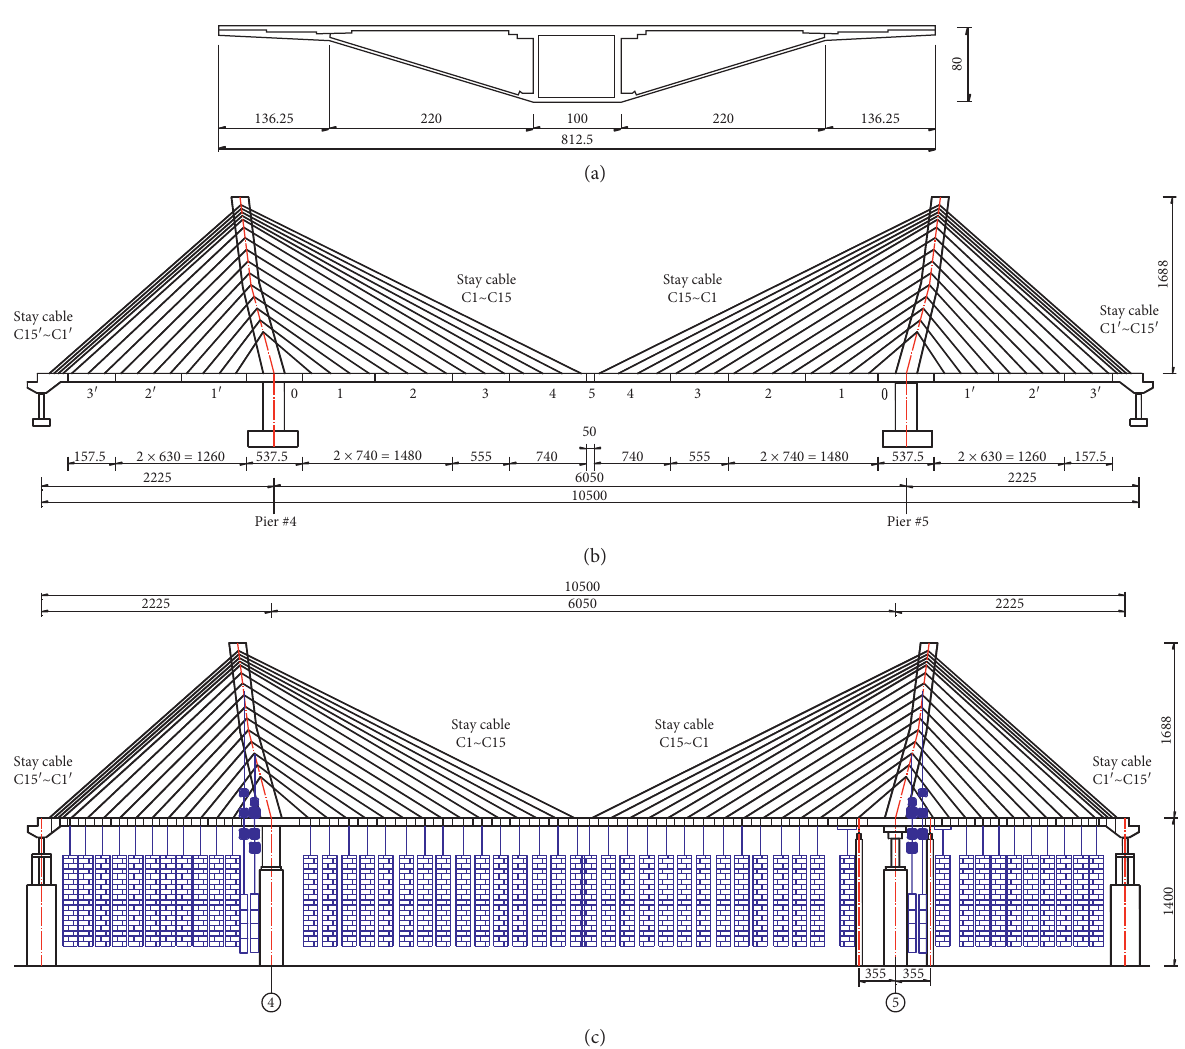
Figure 2: General arrangement drawing of model (unit: cm). (a) Mid-span section diagram. (b) Block diagram. (c) Temporary support and loading